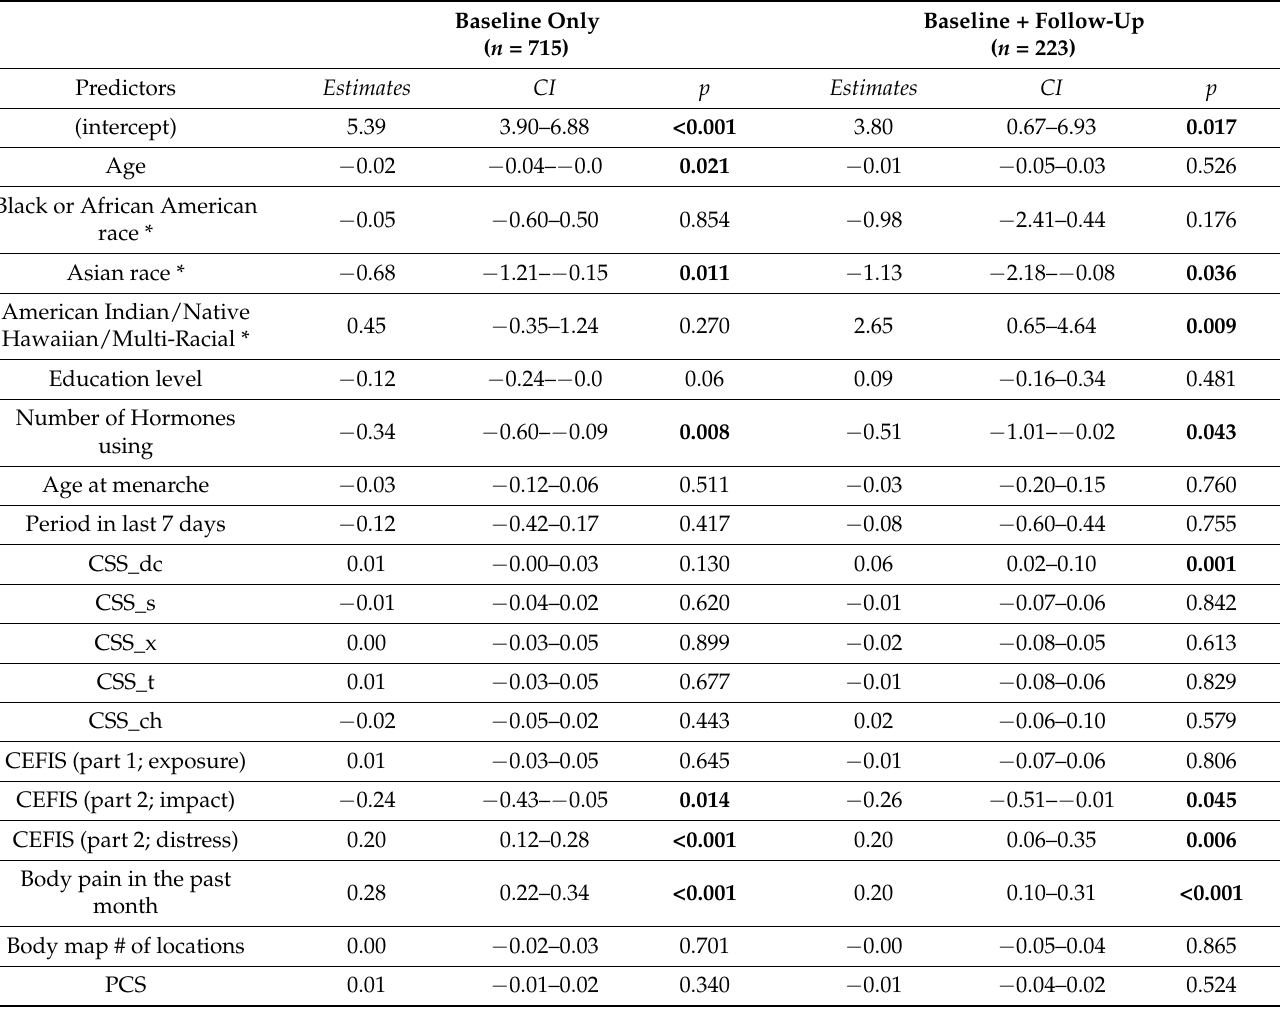
Table 2. Predictors of Average Menstrual Pain in participants who completed the baseline assessment only and those who completed both baseline and follow-up